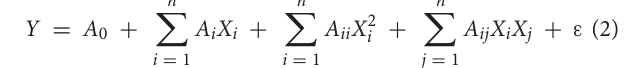
FIGURE 1 | Critical micelle concentration (CMC) of biosurfactant produced by Bacillus sp. SHA302 (in Bushnell-Haas culture medium with carbon sources of glucose and n-hexane for 96